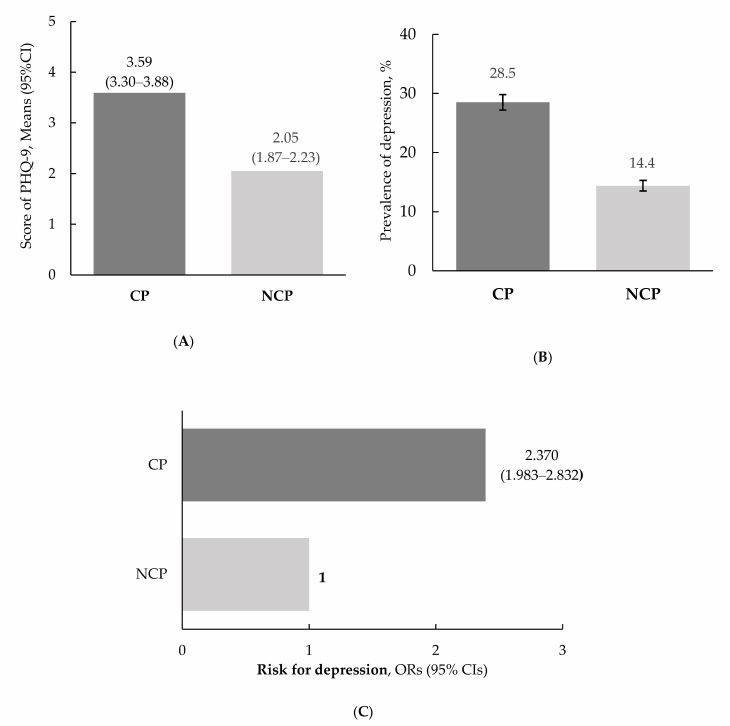
Figure 1. Depression according to chewing problems. ( A ) Scores on the patient health questionnaire- 9. The data are presented as estimated means (95% CIs), and the p -value for comparisons of variables in relation to chewing problems was assessed using a t -test ( p < 0.001). ( B ) Prevalence of depression. The data are presented as estimated percentages (SE), and the p -value between chewing problems was assessed using the x 2 -test ( p < 0.001). ( C ) Risk of depression. The data are presented as